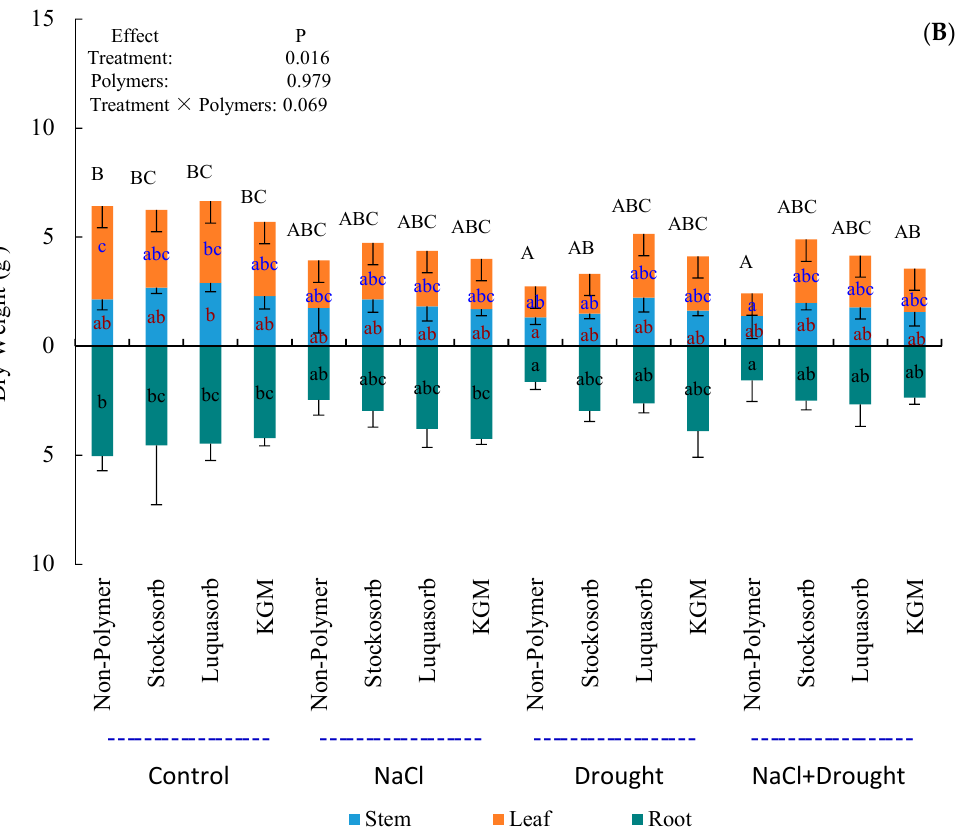
Figure 3. Effect of drought and salt stress on height increment and biomass in Metasequoia glyptostroboides seedlings. ( A ): Shoot height increment. ( B ): Plant dry weight. Columns show samples amended with synthetic (Stockosorb, Luquasorb) and natural (Konjac glucomannan, KGM) hydrophilic polymers and those not amended (Non-Polymer). Each column represents mean analysis of three to five individual plants and bars represent the standard error of the mean. Columns labelled with different letters (a–f) are significantly different at the p < 0.05 level. (Note: Columns labelled with A, B, and C, indicate significant difference in whole-plant dry weight between treatments).